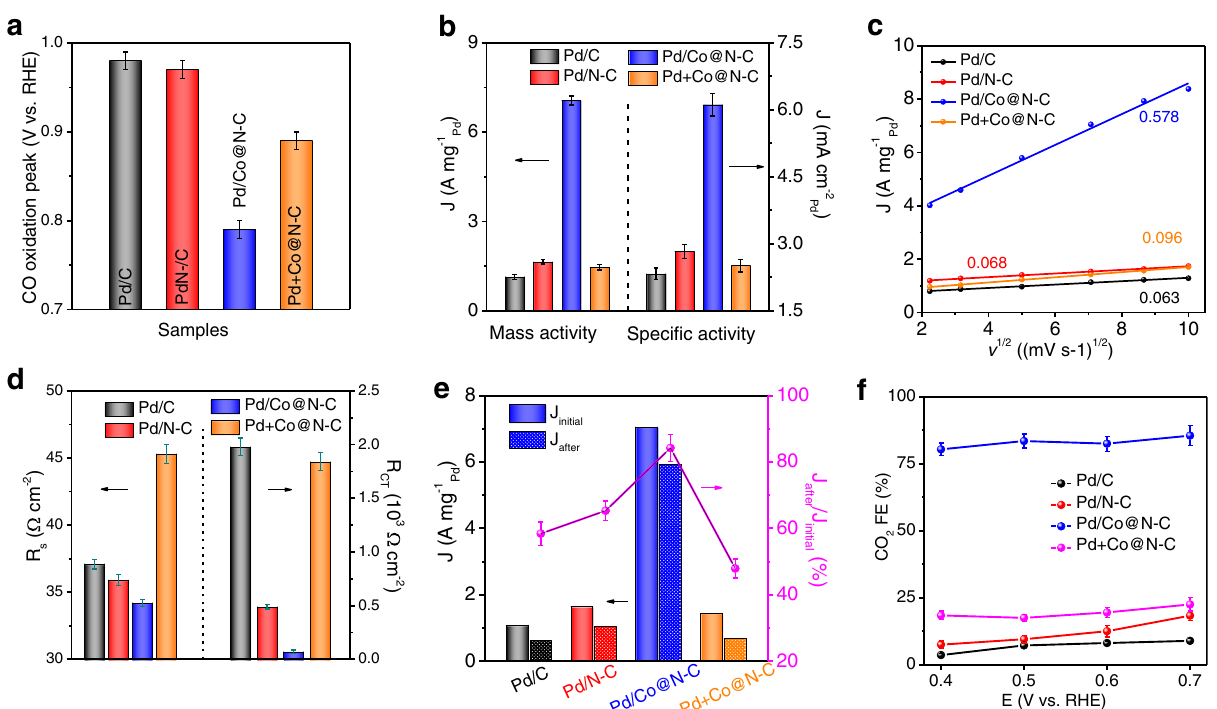
Fig. 3 | Synergistic interface effect of Pd/Co@N-C for electrocatalytic EOR performance. a The CO oxidation peak on different samples with a scan rate of 20mV dec − 1 . b Peak current density (J) normalized to Pd loading (left) and ECSA (right) of Pd/C, Pd/N-C, Pd/Co@N-C, and Pd+Co@N-C. c J as a function of the square root of the scan rate (v 1/2 ). d The system resistance (R s, left) and charge transfer resistance (R CT , right) at 0.6 V RHE for different samples. e Left axis: EOR